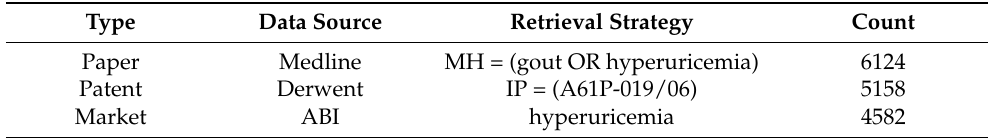
Table 1. Database for data-driven TRM.